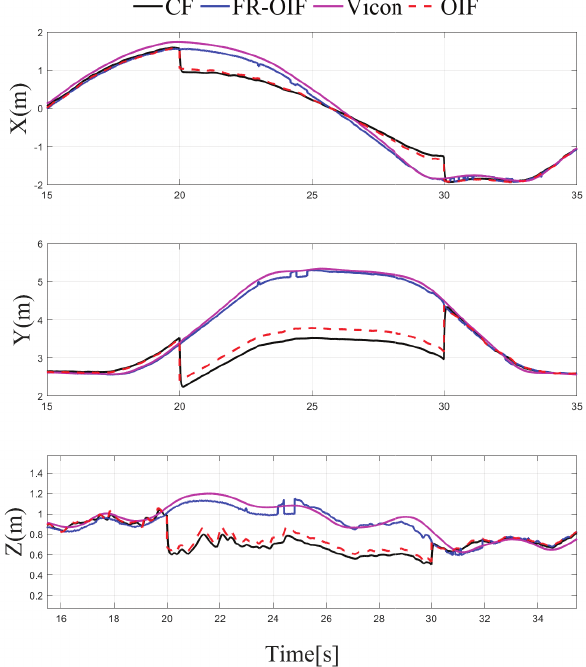
Figure 8. Case-1: Comparison of estimated position obtained from CF, OIF, FR-OIF and Vicon based ground truth, visualization in an emphasized mode of Figure 5 is presented. In the presence of a fault in the LIO for the duration of operation between (20–30) s, the centralized and classical OIF approach is unable to recover the failure in the estimated states, while the proposed FR-OIF successfully recovered from the faulty measurements and it is able to provide a close approximation of position estimate comparable with ground truth.